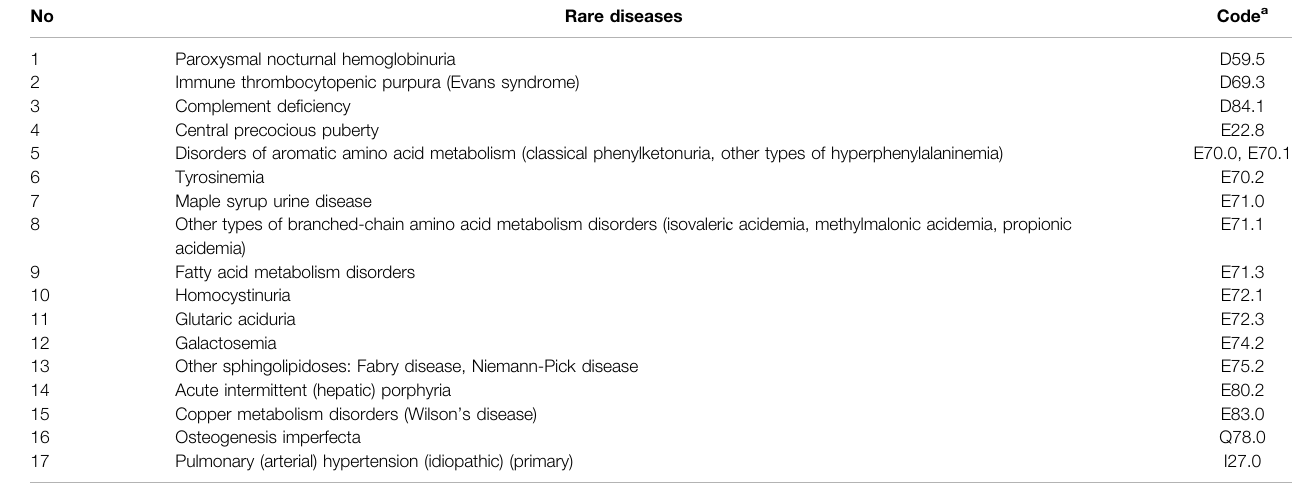
TABLE 2 | The regional list of life-threatening and chronic progressive rare diseases, leading to a reduction in life expectancy of citizens or their disability.